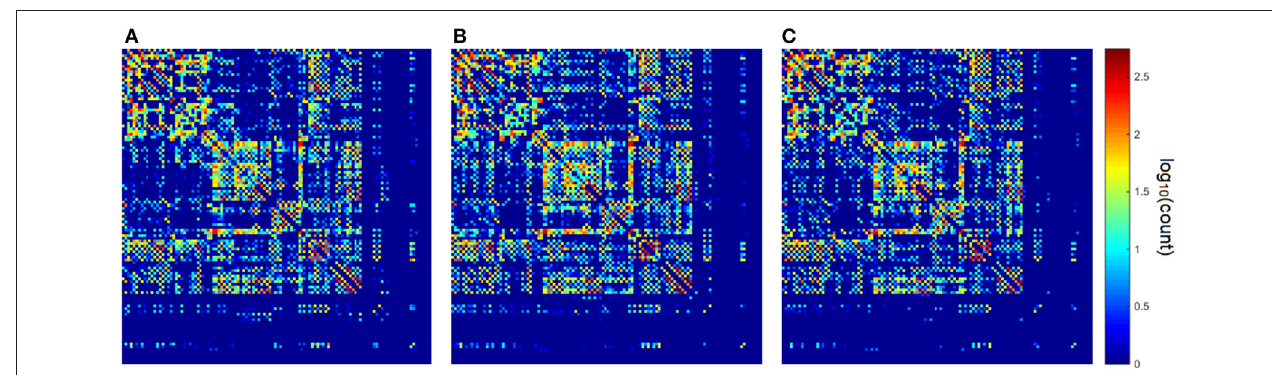
Frontiers in Neuroscience |